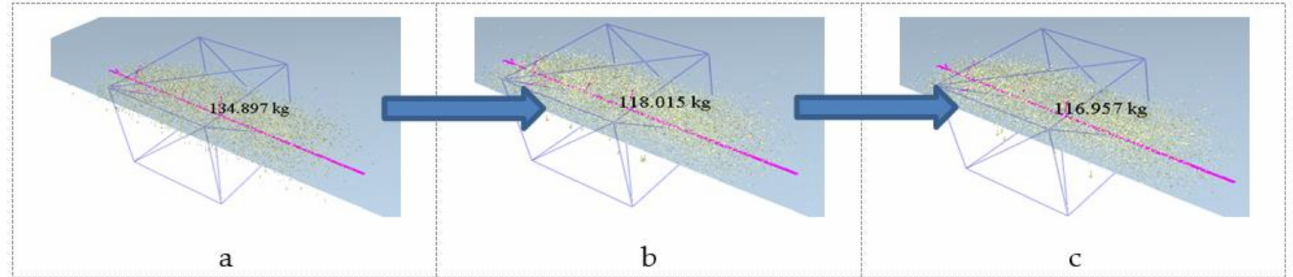
Figure 17. Simulation process of airduct mouth direction angle, 0 ◦ . ( a ) soil ridge mass at 0.5 s/(kg), ( b ) soil ridge mass at 1.5 s/(kg), ( c ) soil ridge mass at 2 s/(kg).